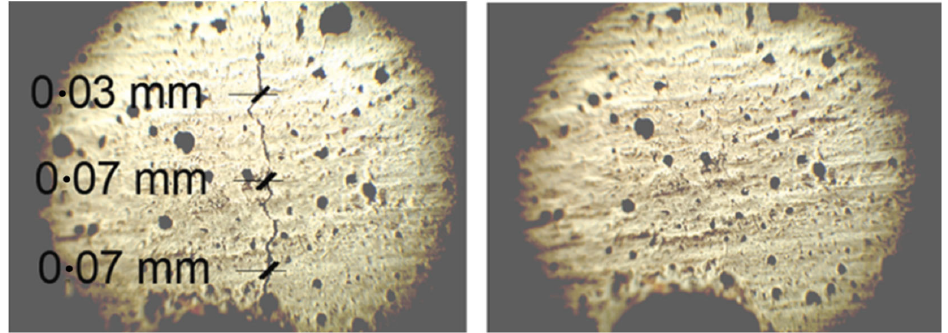
Figure 8. Crack width measurements before and after the hybrid tendons activation. Adapted from [43].